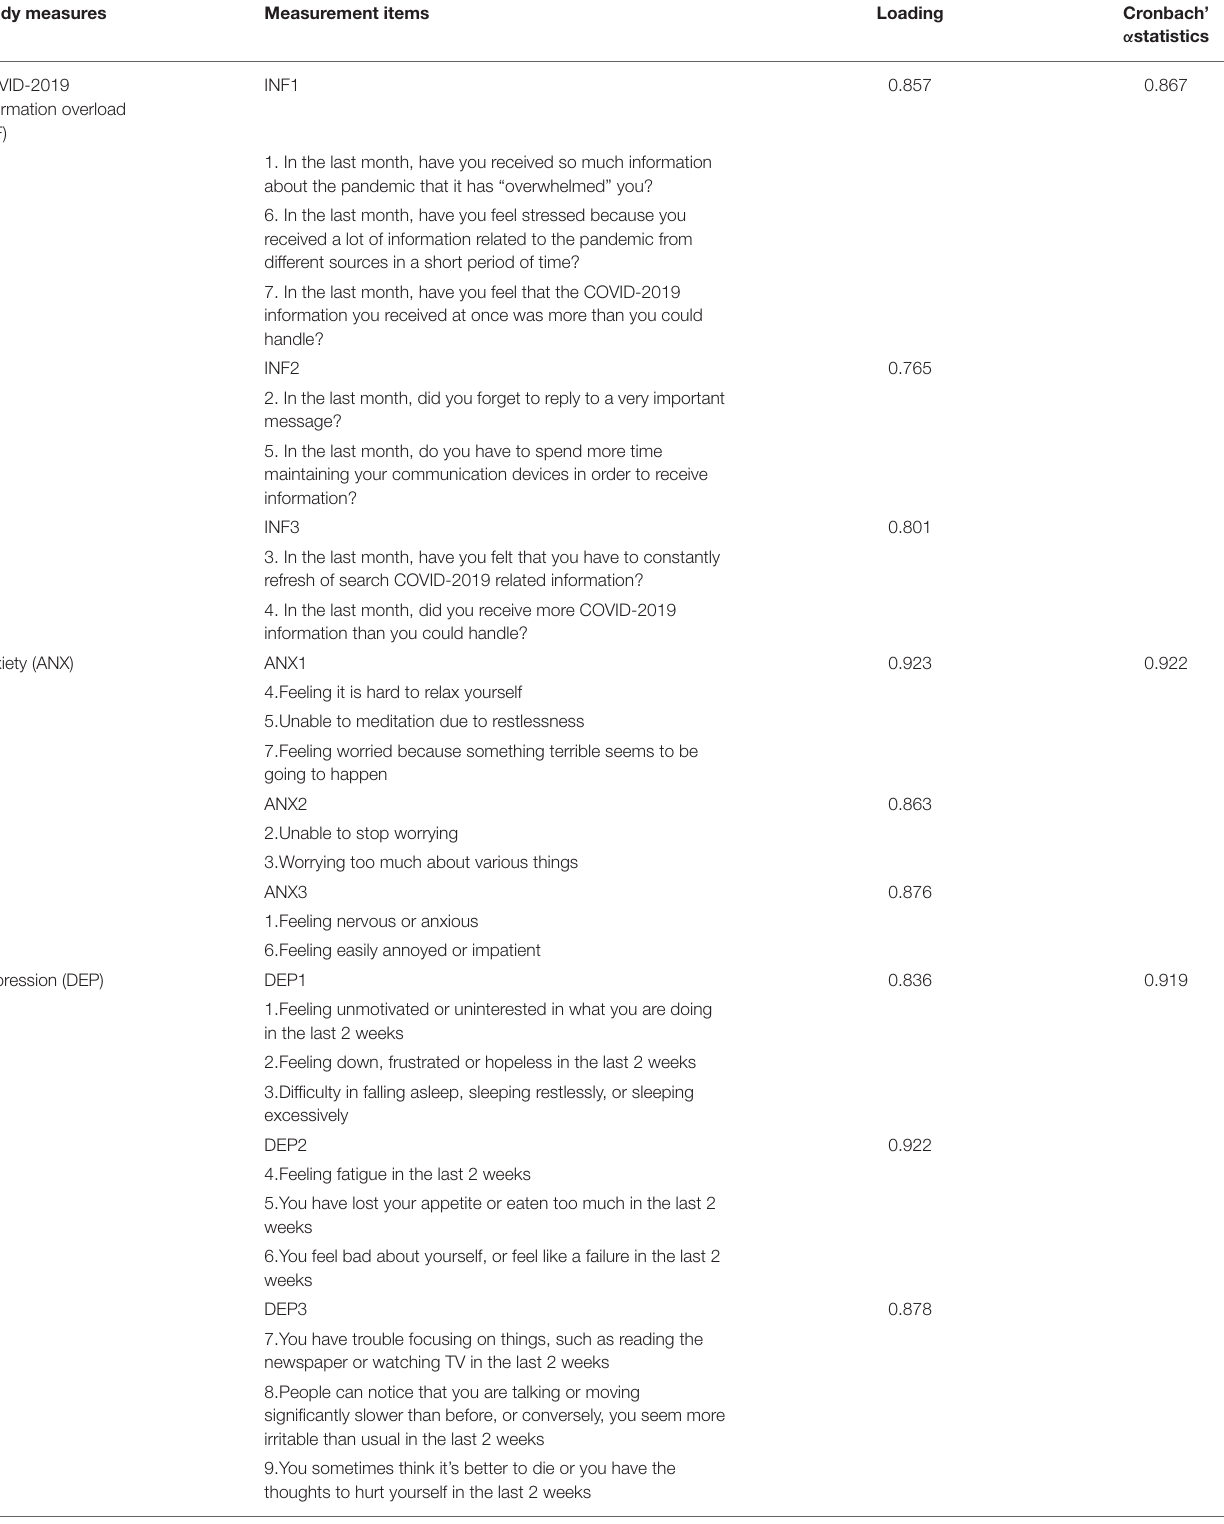
TABLE 4 | Cronbach’s α statistics, loadings of the